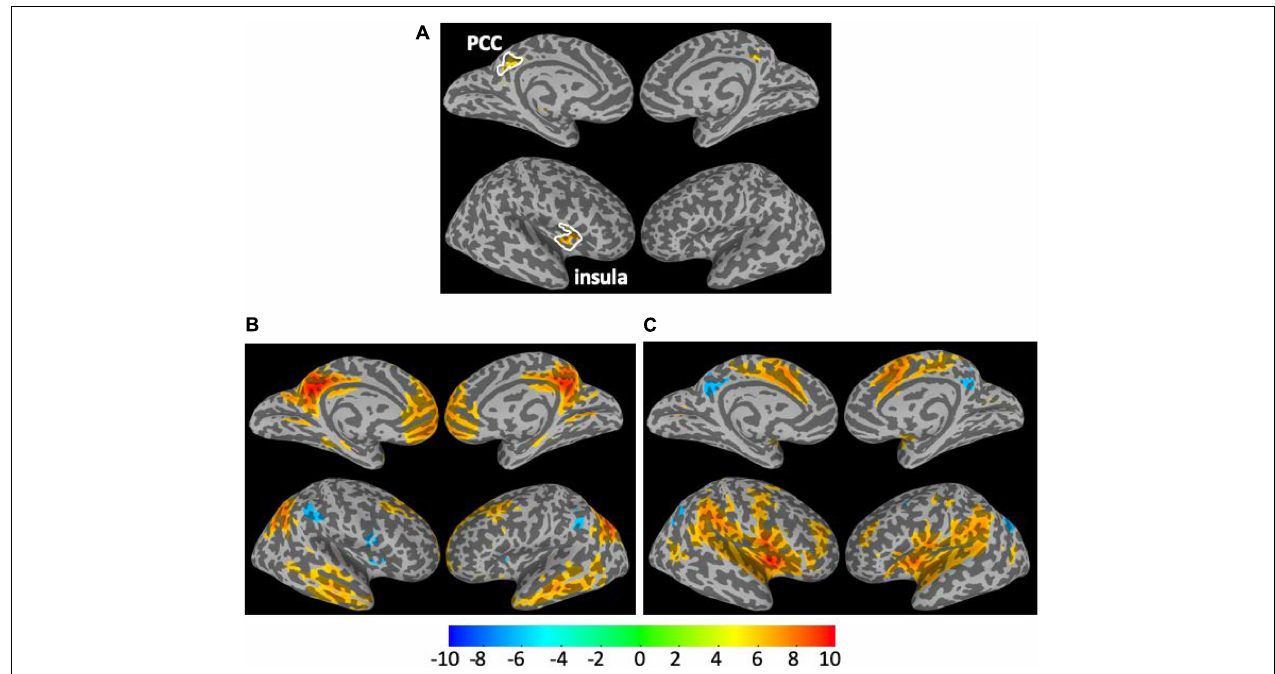
FIGURE 7 | The overlapping ROIs in the PCC and right insula cortex where both the CSI P and CSI N metrics depict significant decline with the adult age (A) . The one sample t -test maps for the Pearson’s correlation maps associated the seeds defined as the overlapping ROI in the PCC (B) and insula cortex (C) .